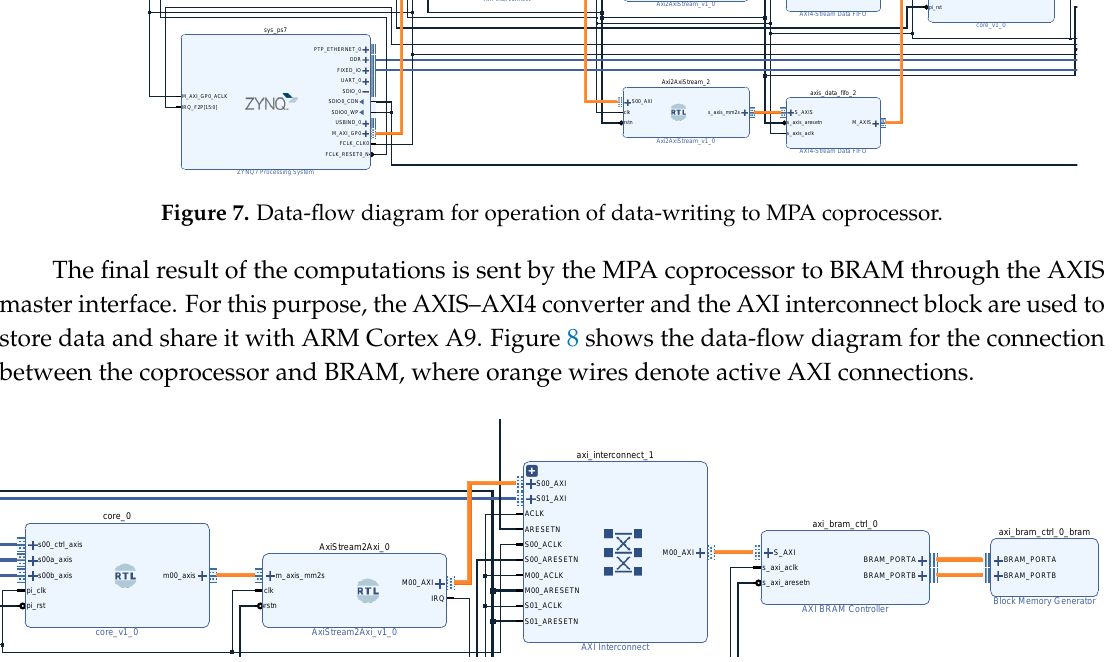
Figure 8. Data-flow diagram for data-writing operation to block random access memory (BRAM) from MPA